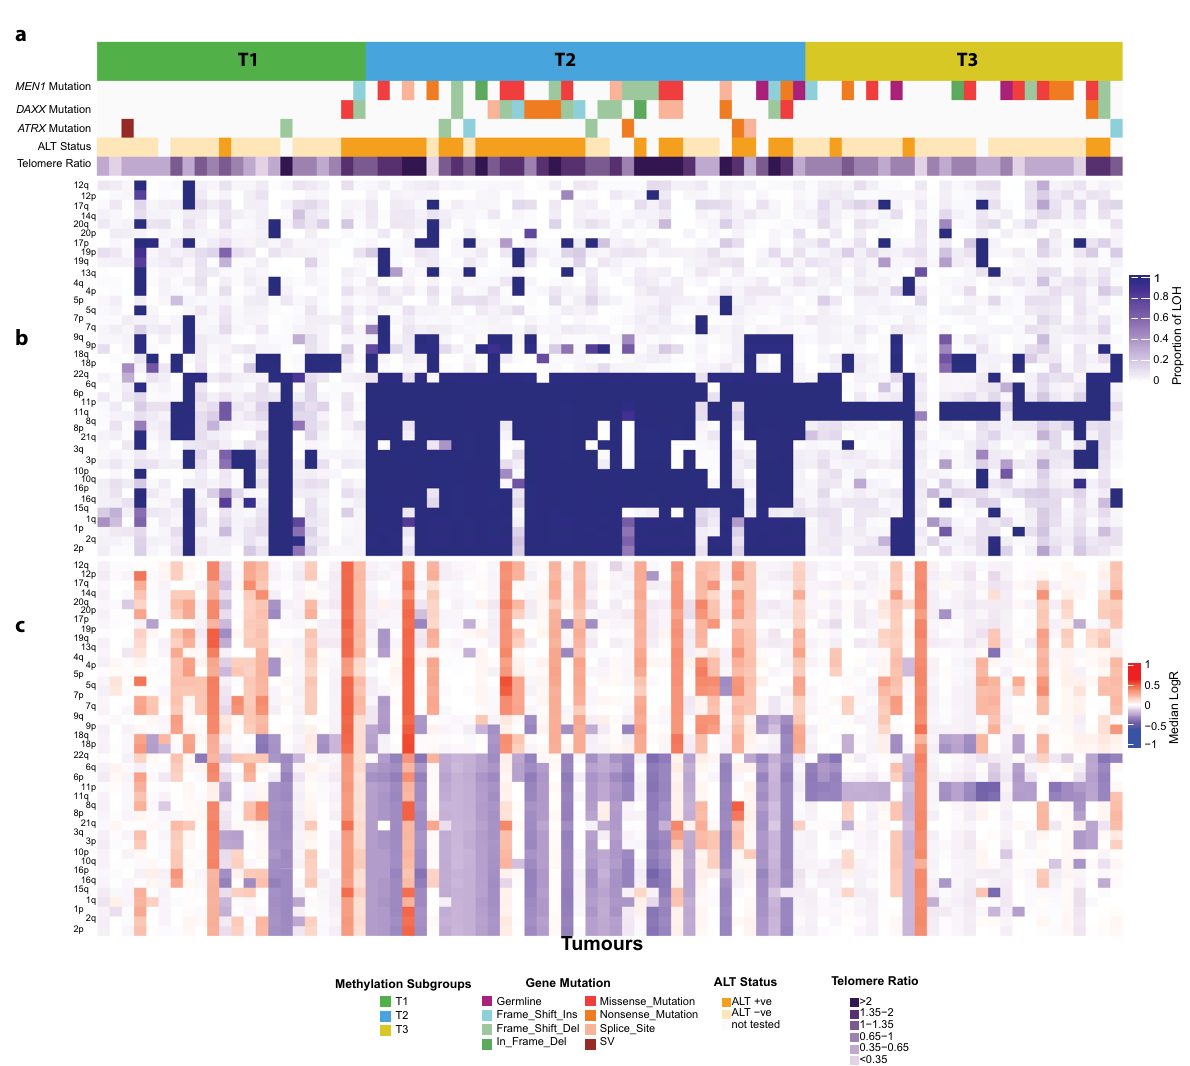
Fig. 2 Association of methylation subgroups with genomic features. Tumour (columns) are presented in the same order as dichotomized clustering presented in Supplementary Fig. 1. a Mutations in ATRX , DAXX and MEN1 genes, alternative lengthening of telomeres (ALT) and telomere length. b Proportion of the chromosomes arms affected by LOH. c Median logR ratio across chromosome arms as a reference to copy number changes (by providing an estimate of the allelic ratio). Chromosomal arm copy number and LOH (rows) were clustered using Euclidian distances and Ward ’ s clustering methylated in normal adjacent pancreata) to identify differentially methylated between at least one pair of subgroups. Of these, 3603 methylated sites across the entire genome and gain some potential mapped to promoter regions of genes and 7439 mapped elsewhere insight into the biology that may differentiate the groups. We in the genome. A total of 6185 CpG sites were differentially identi fi ed 11,042 GpG sites (out of 411,159) differentially methylated between subgroup T1 and T2 ( q < 0.05 and a difference